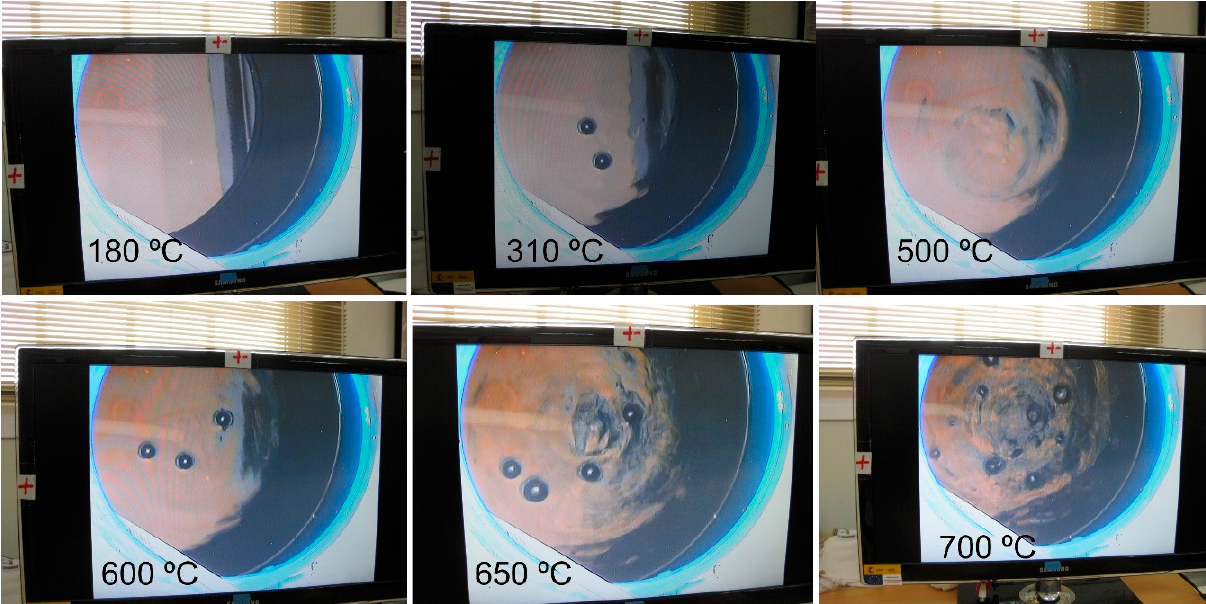
Figure 3. Typical example of bubbles evolution as a function of T during nitriding of Ta powder at 800 °C, for 60 min, and 10 L·h − 1 NH 3 .